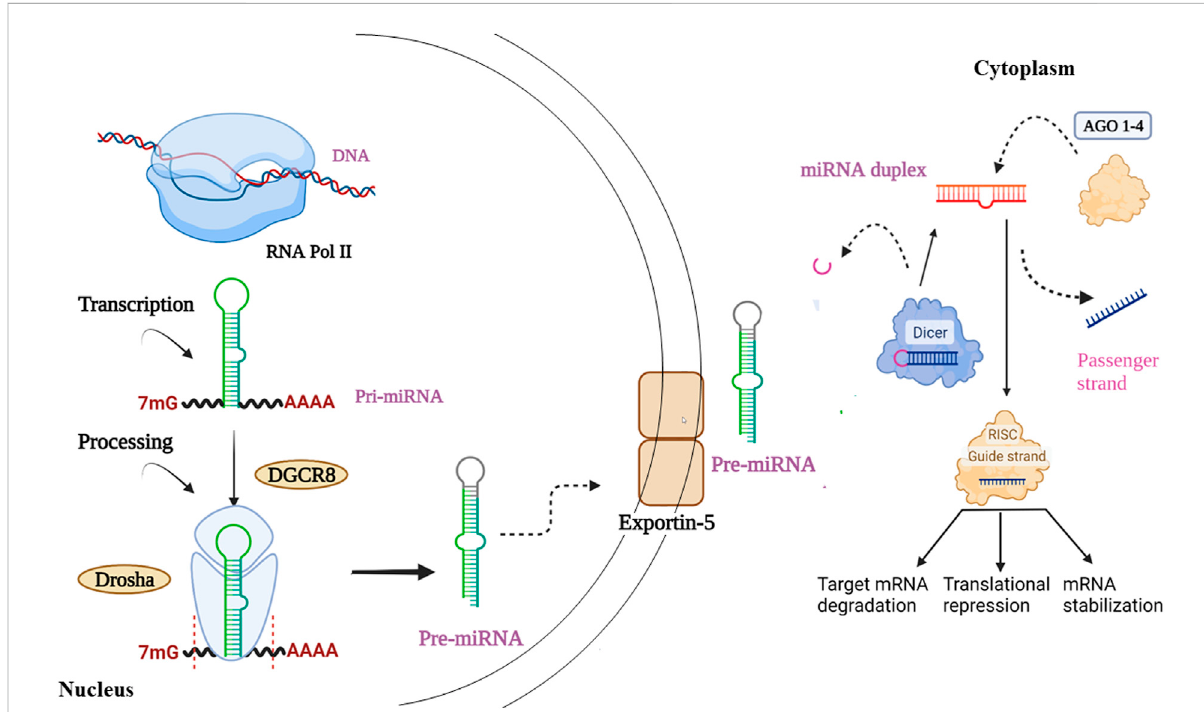
FIGURE 4 Startsrightfromthenucleusinvolvingsequentialproductionof (a) pri-miRNA (b) pre-miRNA,followedbytransportationofpre-miRNAintothe cytoplasm.Furthermore,involvingthegenesisofmiRNAduplex,itsbindingwithAGOproteinand fi